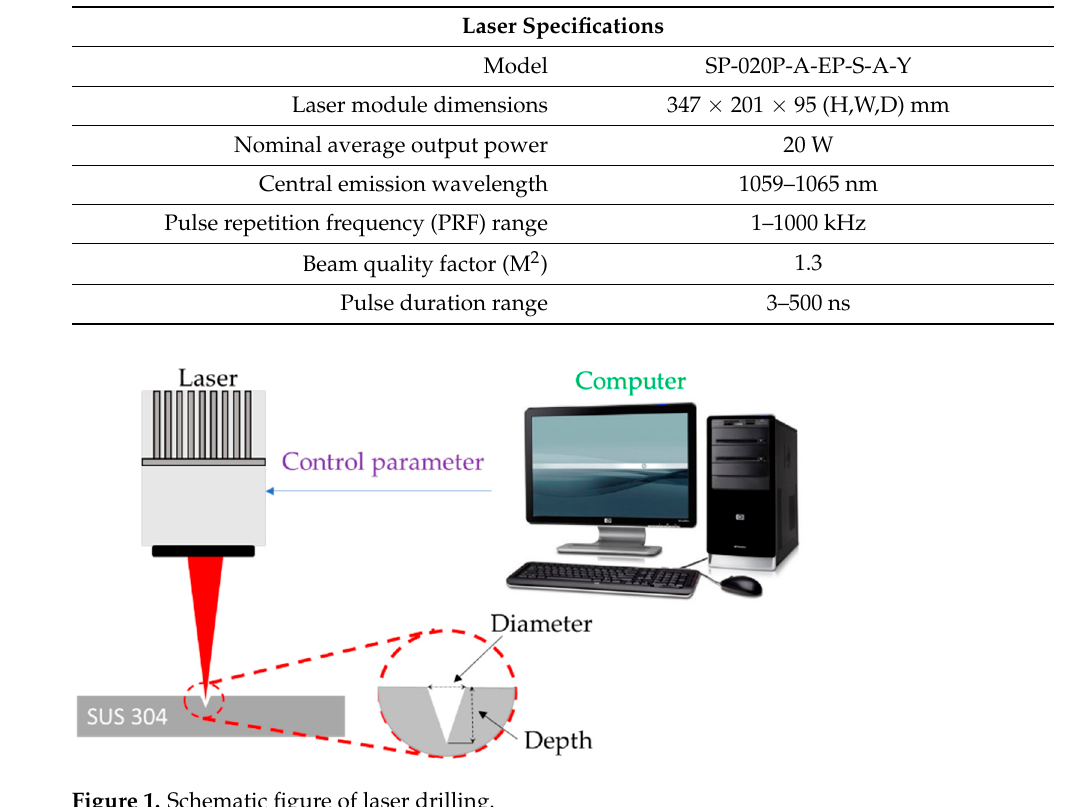
Figure 1. Schematic figure of laser drilling. Table 1. Laser source information. Table 2. 304 stainless steel material